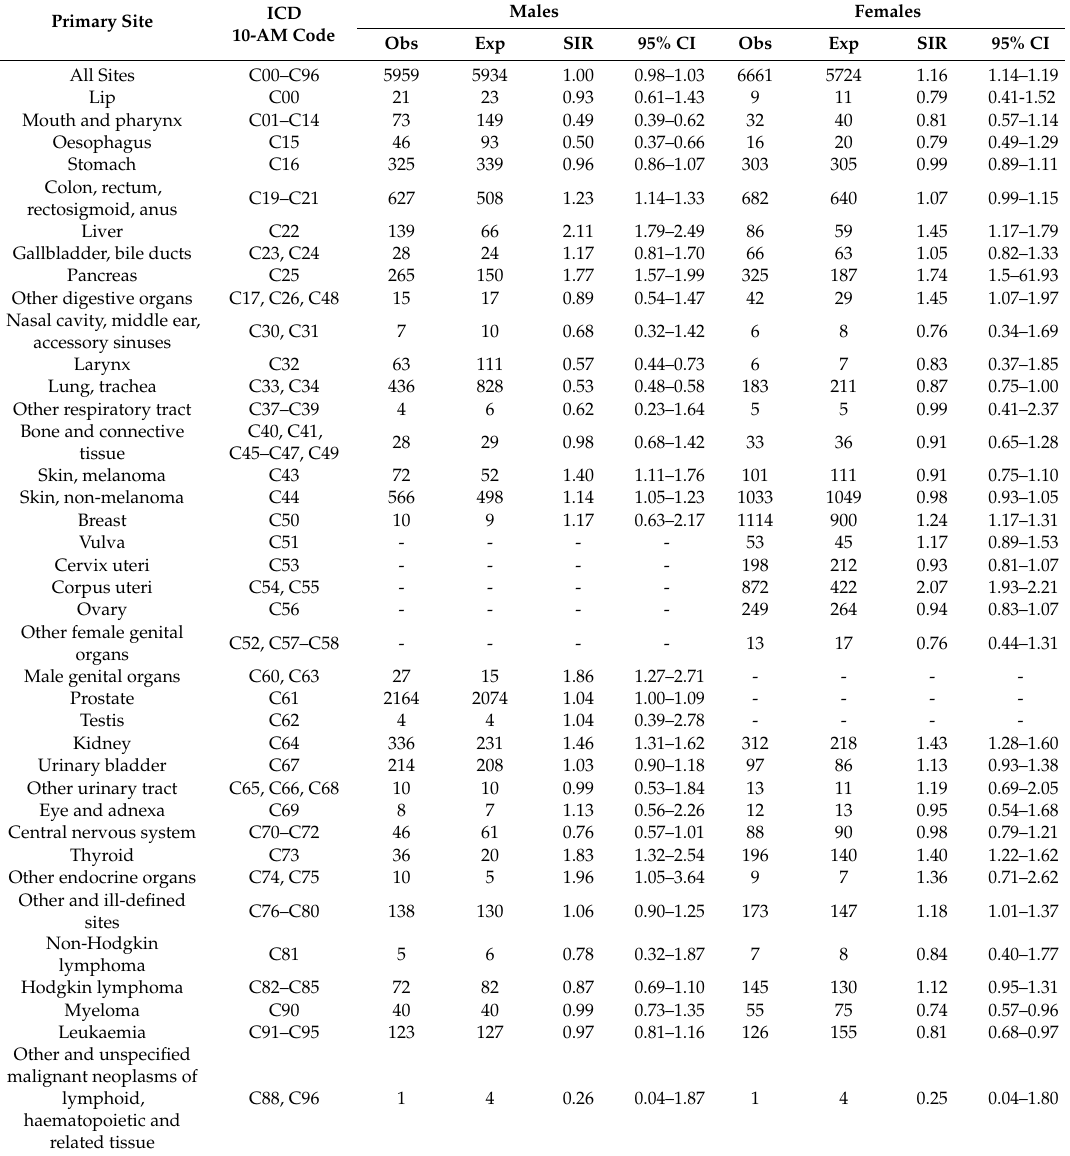
Table 2. Observed and expected numbers of cancer cases and standardized incidence ratios with 95% confidence intervals among Lithuanian type 2 diabetic patients during 2000–2012 by site according to the International Classification of Diseases Australian